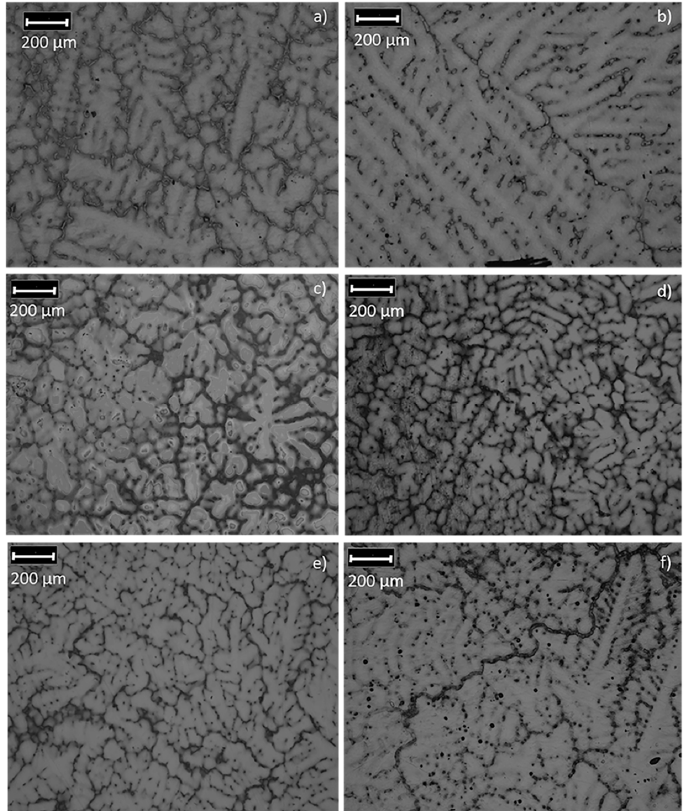
Figure 1. Optical micrographs of the as-cast ( a ) Mg-0.38Ga-1.5Zn, ( b ) Mg-1.12Ga-1.5Zn, ( c ) Mg- 0.75Ga-3Zn, ( d ) Mg-0.38Ga-4.5Zn, ( e ) Mg-1.12Ga-4.5Zn and ( f ) Mg-1.5Ga-6Zn alloys.